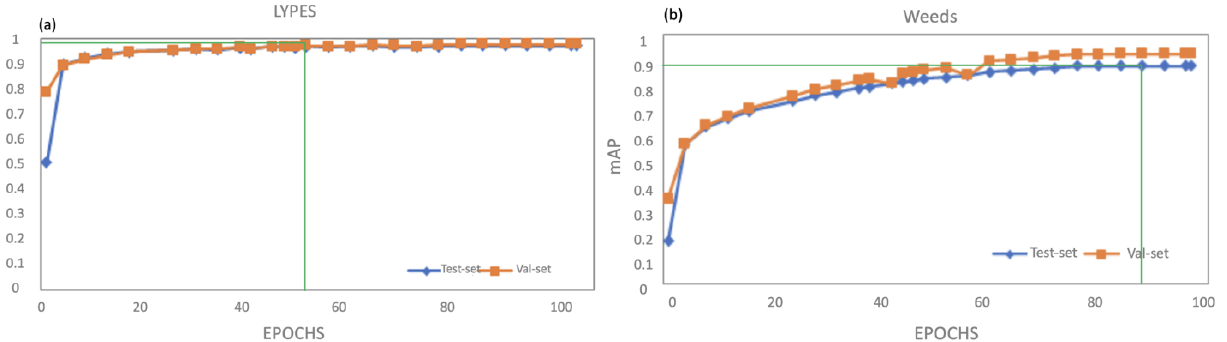
Figure 6. Learning curves of crops ( a ) vs. weeds ( b ) over validation set (square data markers) and test set (rhombus data markers).